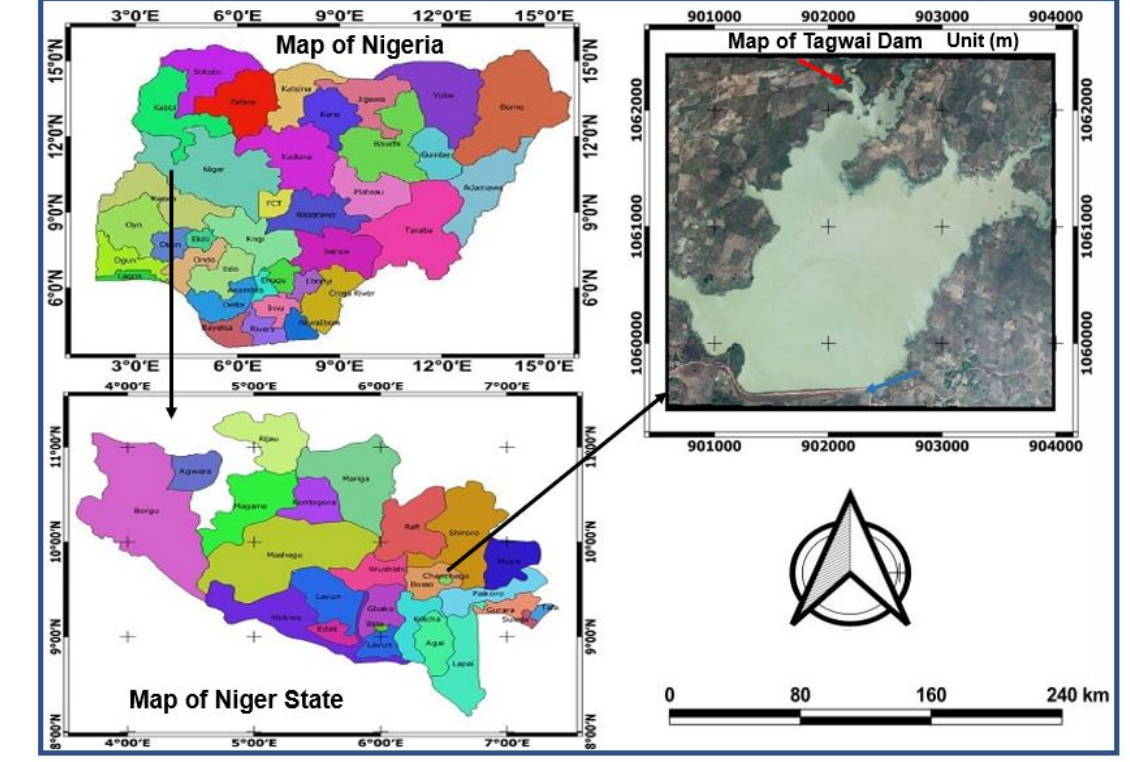
Figure 1. Map of the study area (Source: Google Earth Pro and research lab).